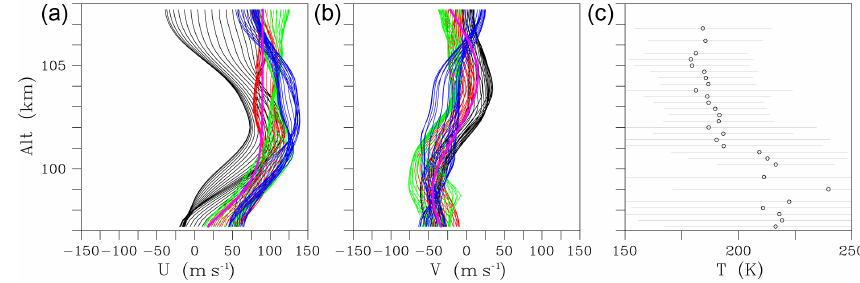
Figure 6. Same as Fig. 5 except for 23:50–01:20LT. The violet curves are models reflecting conditions at